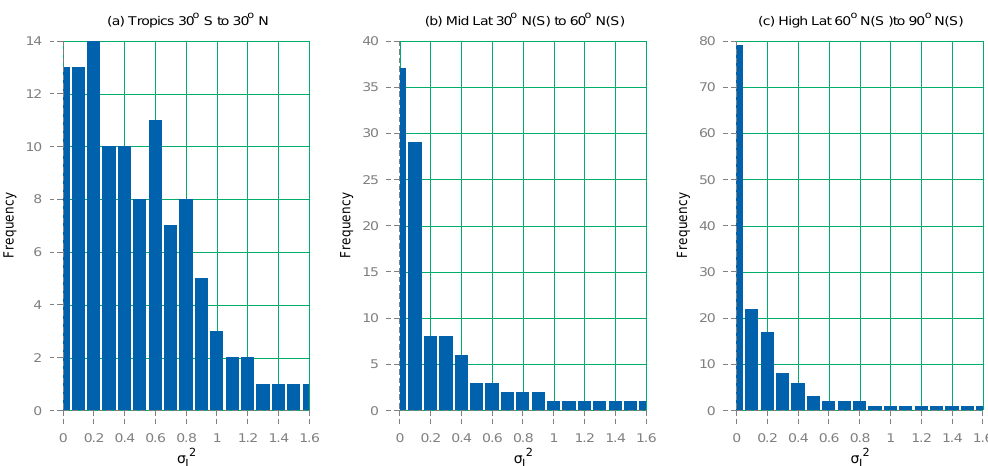
Figure 3. Histogram of σ 2 COSMIC RO averaged over 1–8km: (a) tropics, (b) midlatitude, and (c) high latitude. I inferred map presented in Figs. 1 and 2, therefore, helps to build and enrich the polar region